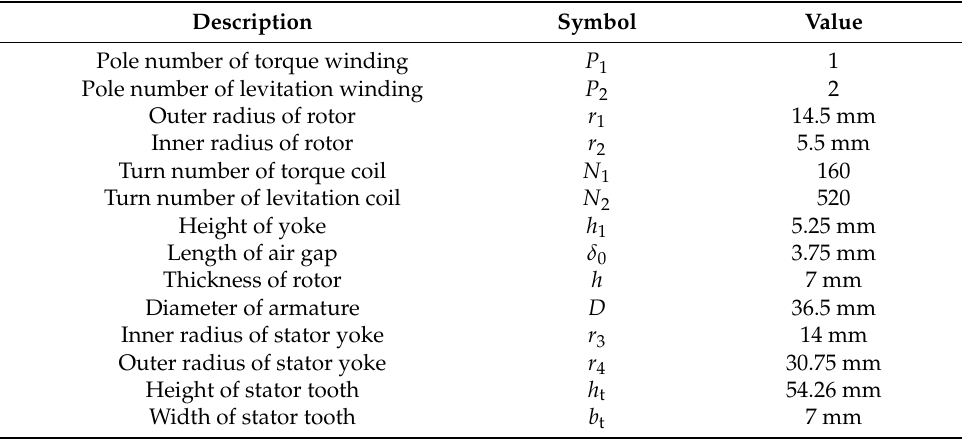
Table 1. Mechanical structural parameters of BPMSM. Description